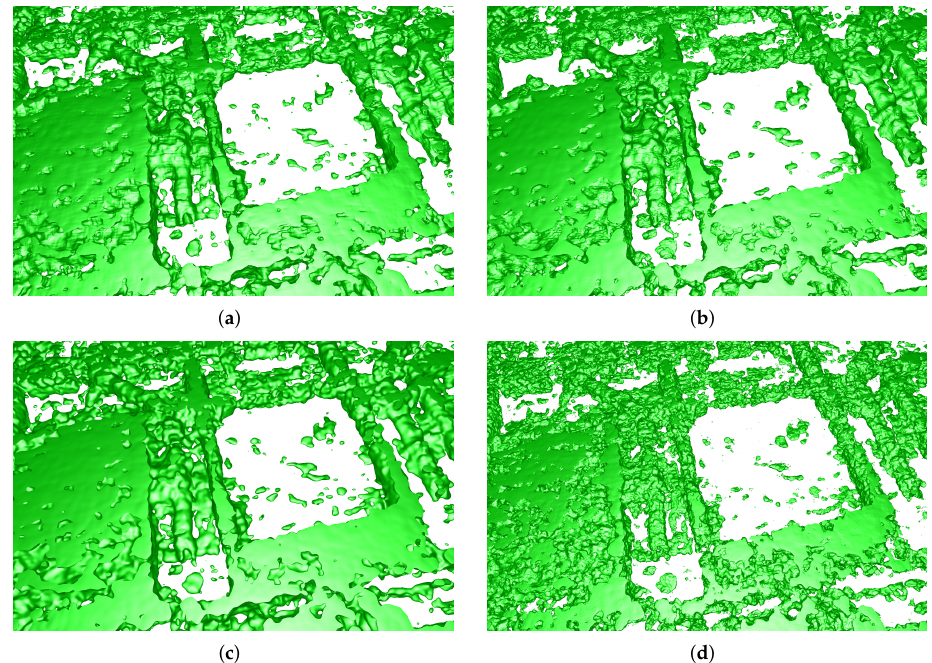
Figure 9. Iso-surface visualization of GPR datasets filtered with a 3D median filter of kernel size 5 ( a ), a bilateral filter ( b ), an edge-enhancing anisotropic diffusion filter ( c ), and a TV-L1 filter λ = 0.75 ( d ). The results are comparable to Figure 8, although DVR preserves slightly more structure surface details. Nevertheless, iso-surfaces of filtered GPR data are a useful complement to DVR.